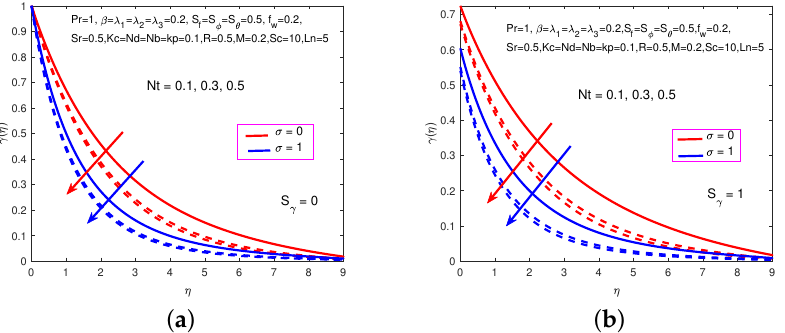
Figure 12. Influence of Nt and σ on γ . ( a ) No nanoparticles concentration slip. ( b ) With nanoparticles concentration